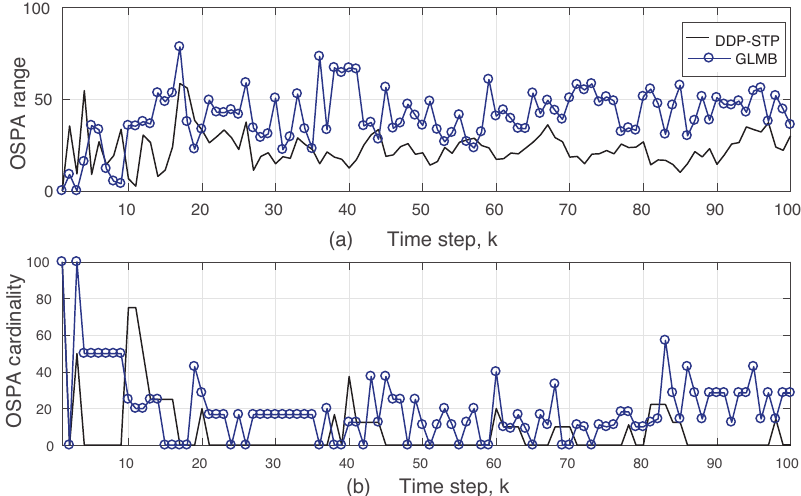
Figure 5. ( a ) OSPA range and ( b ) OSPA cardinality using DDP-STP and GLMB in Expriment